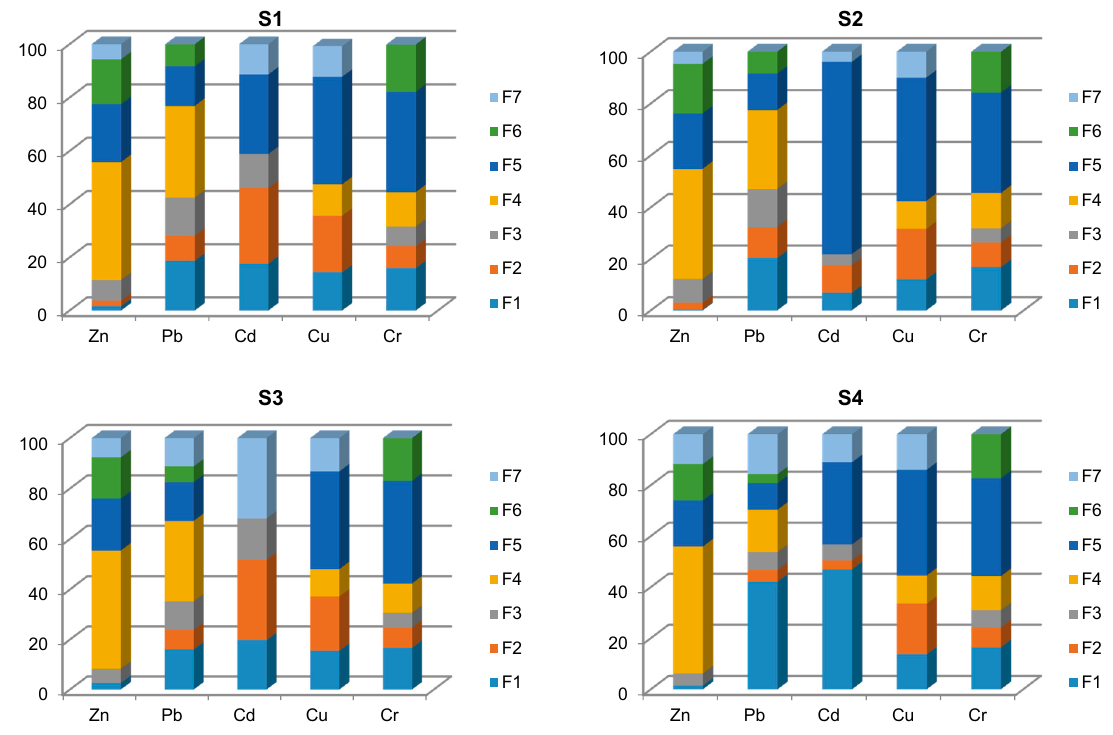
Figure 4. Sequential extraction of fly ashes after hard coal combustion (%).